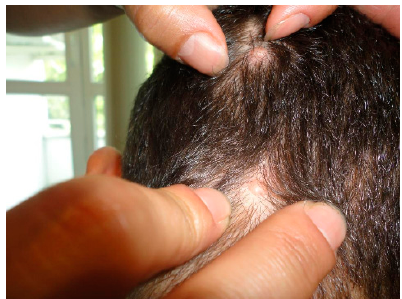
Figure 3. Scalp trichoepitheliomas.